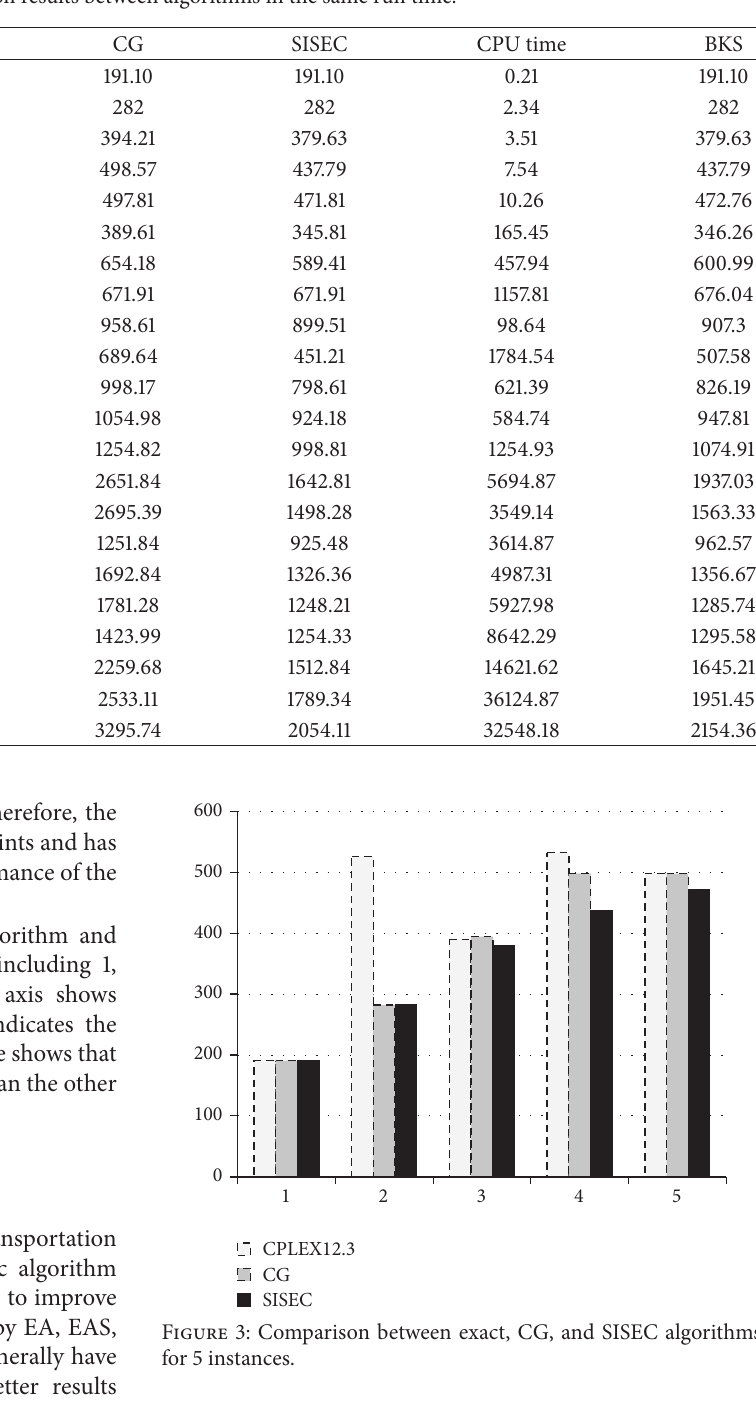
Table 3: Comparison results between algorithms in the same run time.